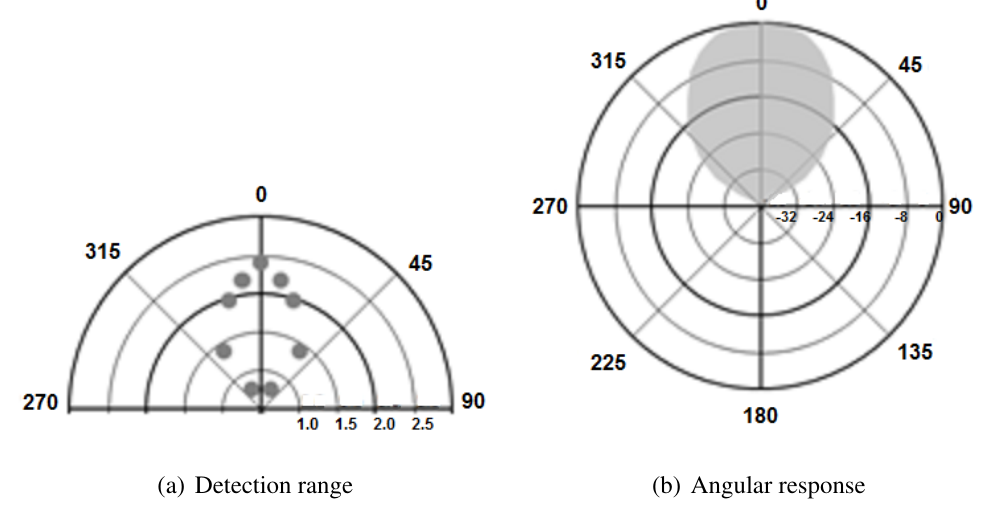
Figure 2. (a) Maximum detected ranges (in meters) to a 55 mm plastic pipes for selected angles, as described in [23]; (b) Approximate angular response in dB of the SRF02 sensor used in the proposed system at half range, as described in